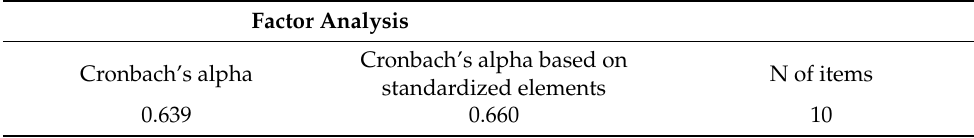
Table 5. Cronbach’s alpha calculation of the second